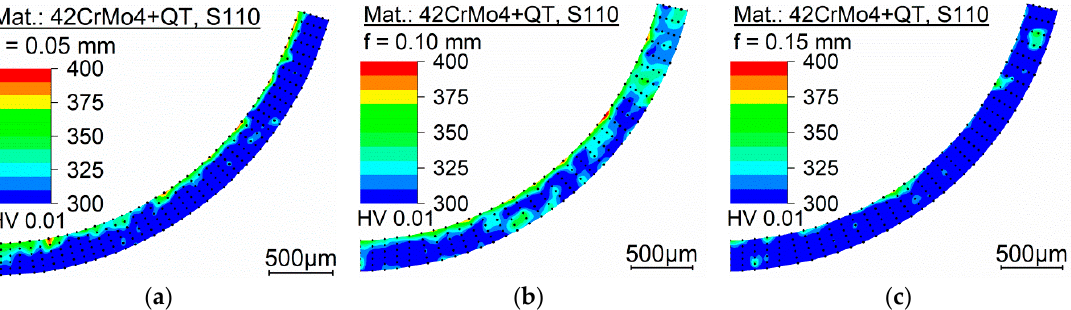
Table 2. Results of tactile roughness measurements on S110 specimens.